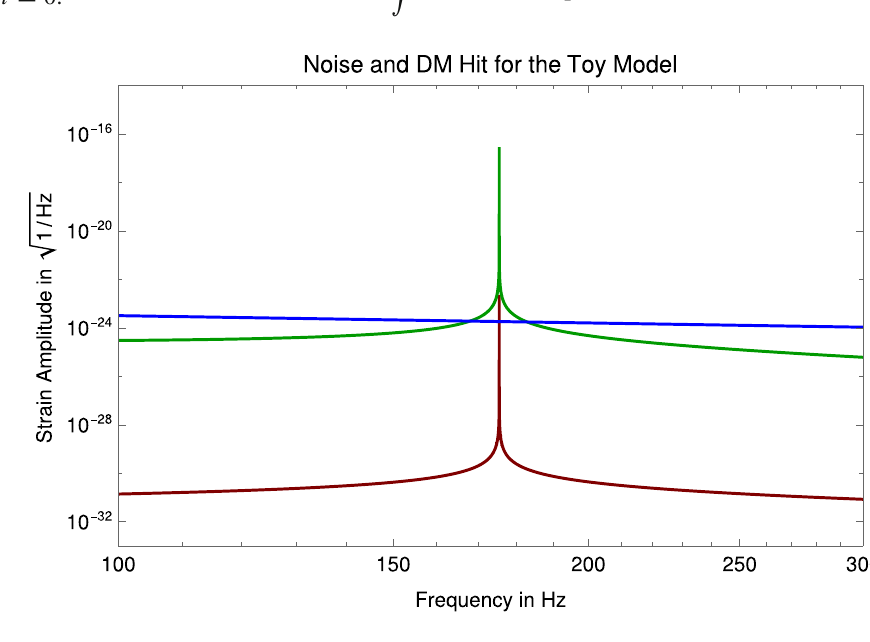
Fig. 1 The strain amplitudes in our toy model for the thermal suspension noise (green line), the quantum noise (blue line) and a hypothetical DM signal (maroon line). For more details, see main